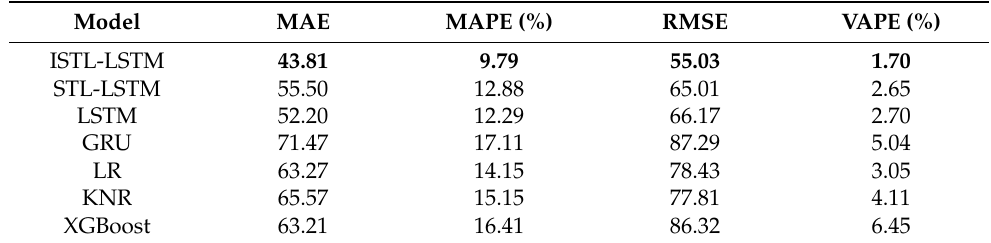
Table 5. Performance comparison of the proposed model and other models. Bold means that these figures are the smallest in each column respectively, which means the best